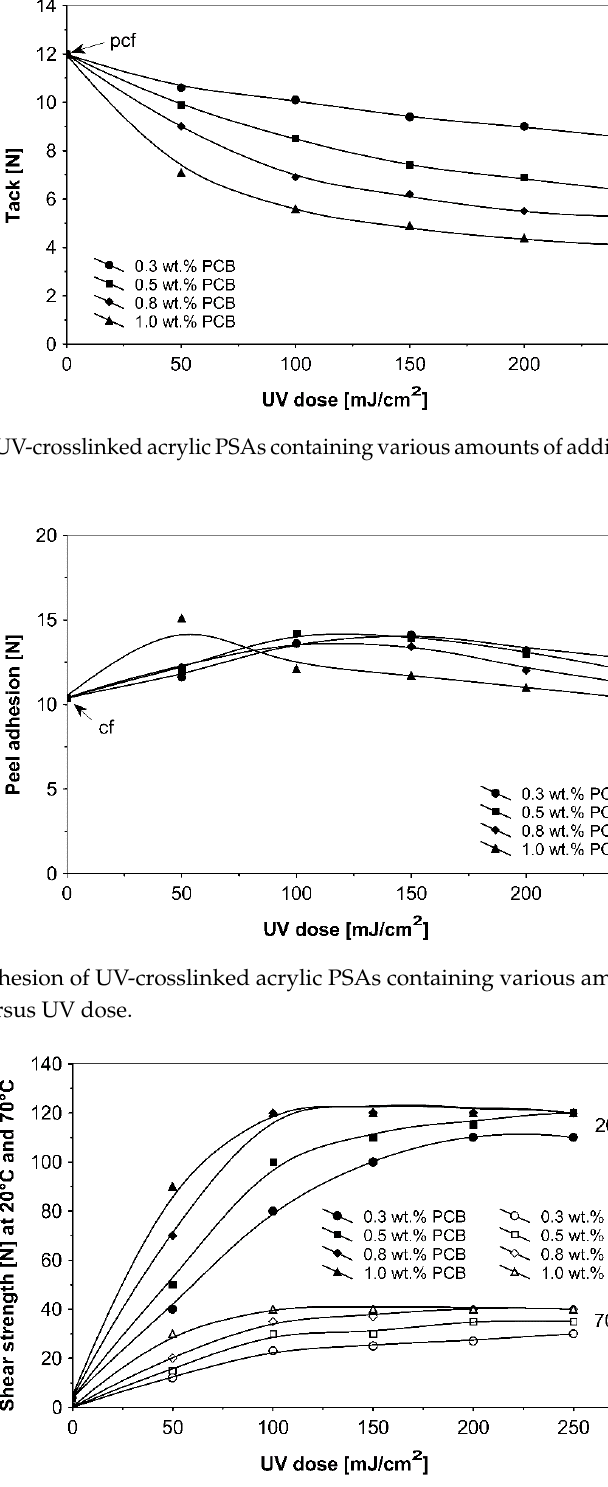
Figure 10. Shear strength of UV-crosslinked acrylic PSAs containing various amounts of additionable photoinitiator versus UV dose .